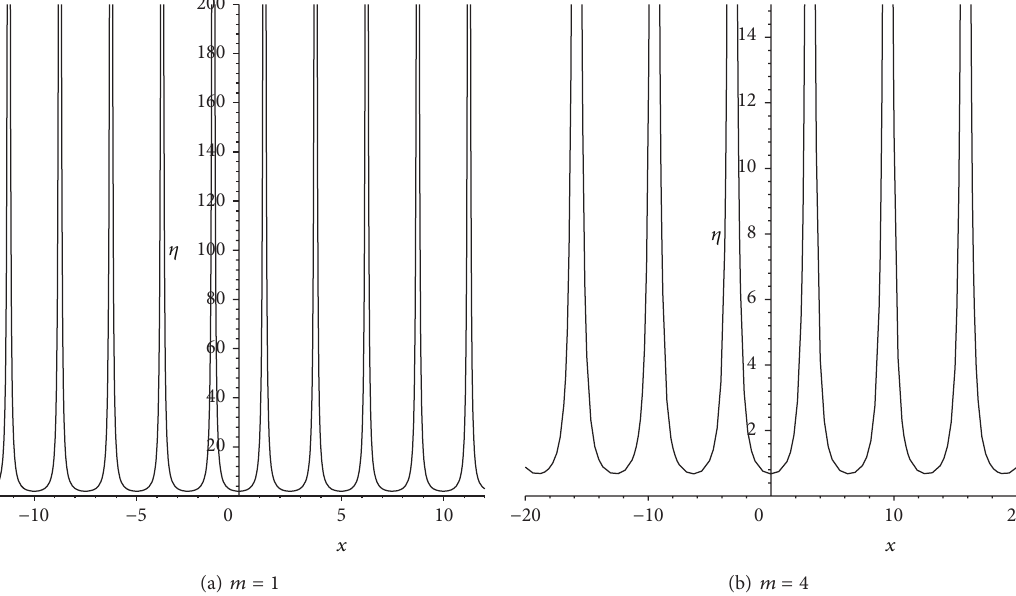
Figure 3: The graphs of solution (61) under some fixed parametric values.